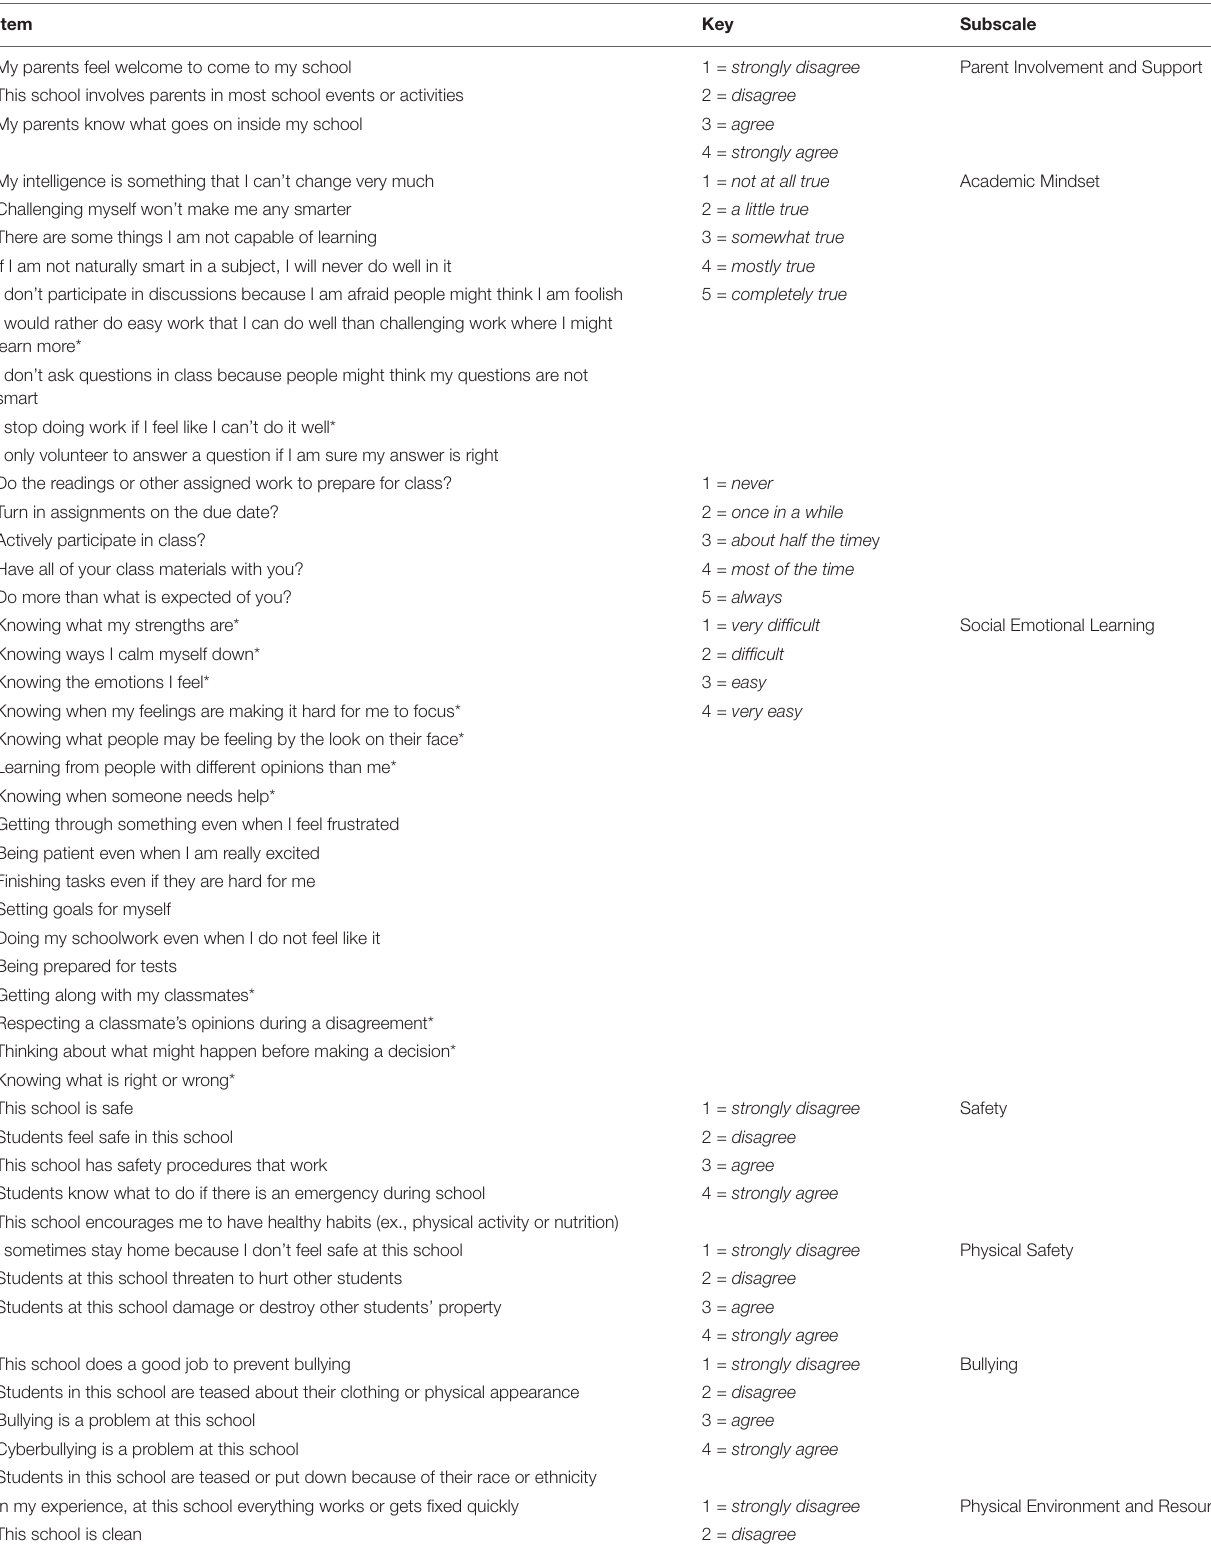
TABLE 1 | School Climate and Academic Mindset Inventory items (original